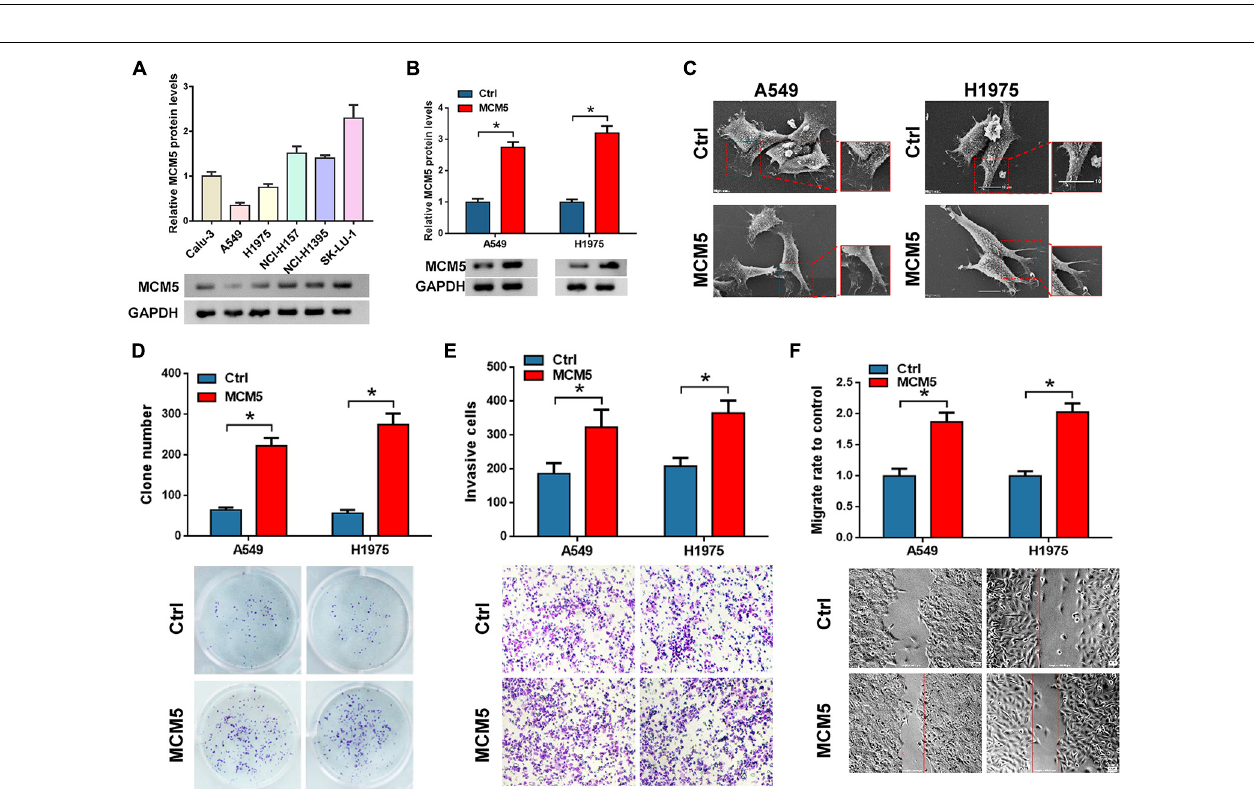
FIGURE 2 | MCM5 promoted the proliferation and invasion of lung cancer cells. (A) Western blots were used to detect the expression of MCM5 in six lung cancer cell lines. Then, we overexpressed MCM5 in A549 and H1975 cells and tested the effect of MCM5 on lung cancer cell function. (B) MCM5 protein level after overexpression of MCM5 in A549 and H1975 cells. (C) Morphological changes in A549 and H1975 cells transfected with MCM5 and observed with SEM. (D) Colony formation of A549 and H1975 cells after MCM5 overexpression. (E,F) Cell invasion and migration of A549 and H1975 cells after MCM5 transfection, respectively. * P <